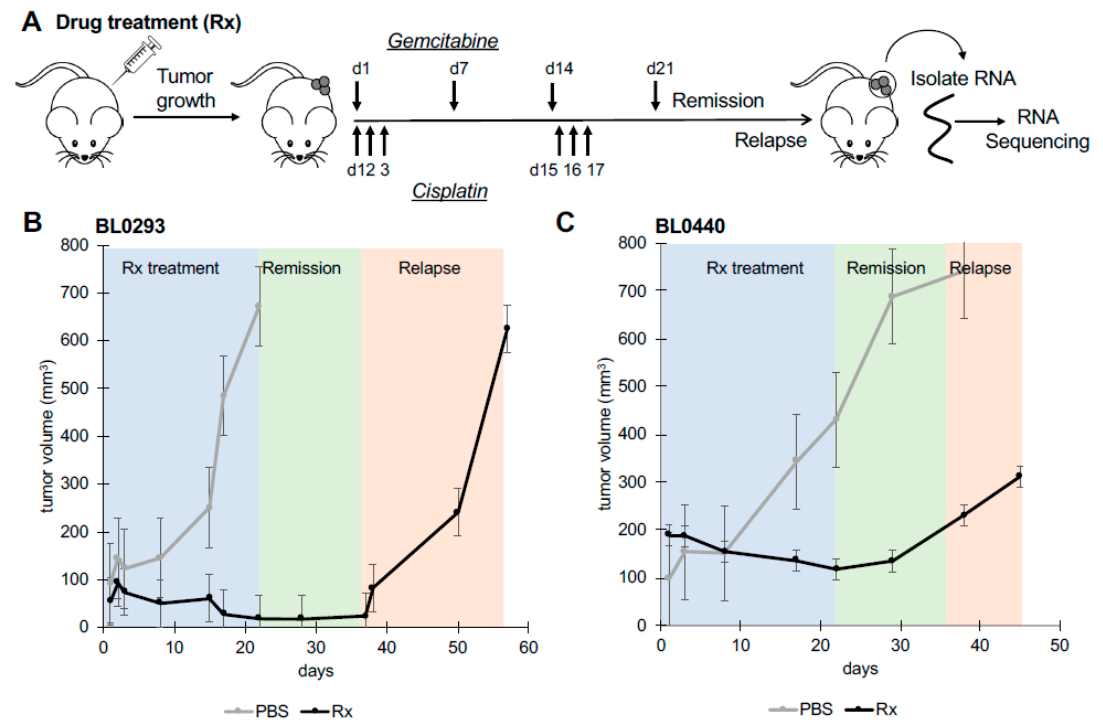
Figure 1. Patient-derived bladder cancer xenograft (PDX) tumors BL0293 and BL0440 relapse following combination drug therapy. ( A ) Drug dosing was initiated when tumors reached ~100–150 mm 3 in size and occurred over 21 days with experimental mice (drug treated (Rx)) ( n = 5) and phosphate bu ff ered saline (PBS) control mice ( n = 3) treated concurrently with gemcitabine (intraperitoneally) and cisplatin (intravenously). Tumor growth was measured weekly for ( B ) BL0293 and ( C ) BL0440. RNA was isolated from PBS and Rx tumors at last time point recorded.